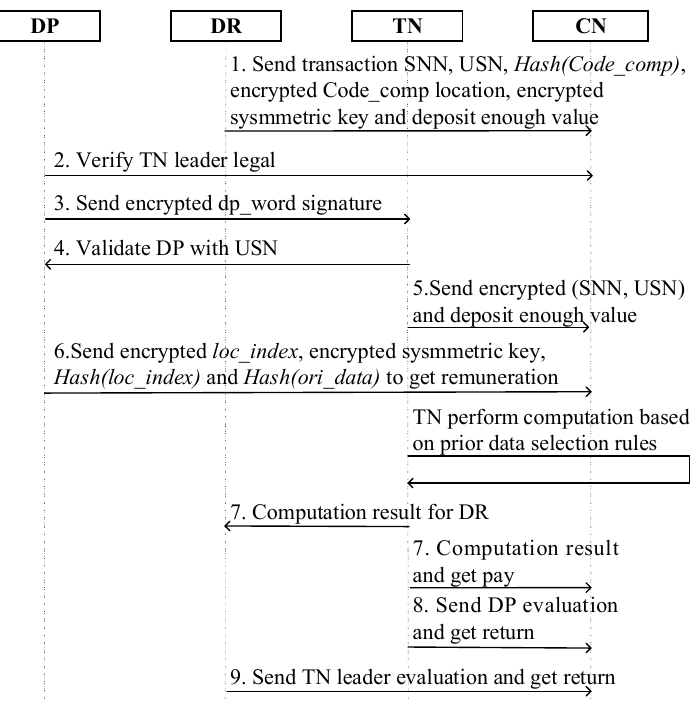
Figure 5. The hybrid transaction phase of SPPCS.